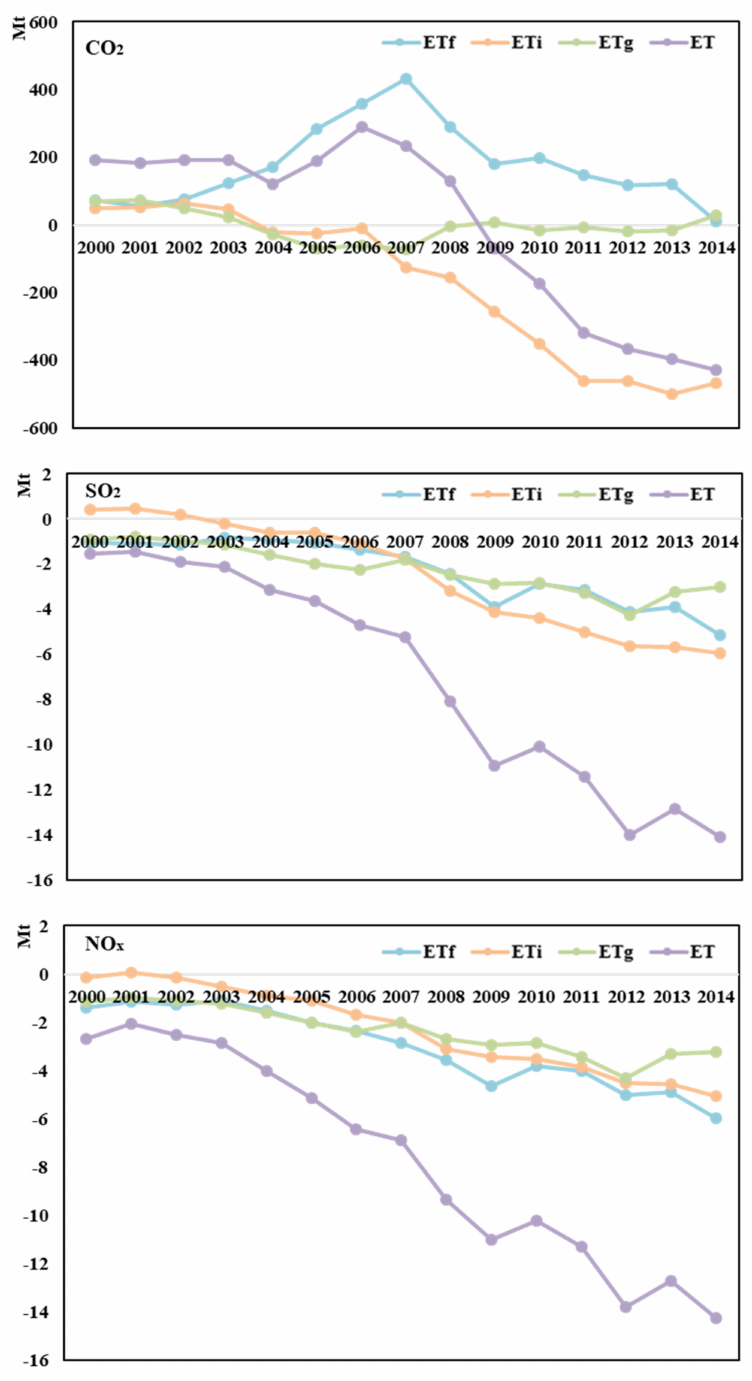
Figure 4. Global pollution haven under different trade patterns from 2000 to 2014. See the details from Appendix E Table